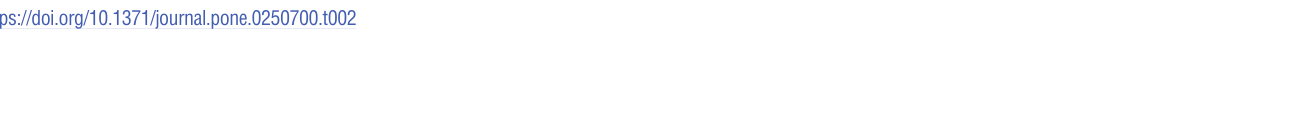
LASIK = laser-assisted in situ keratomileusis; SD = standard deviation; SMILE = small-incision lenticule extraction; Δ = 3-month postoperative minus